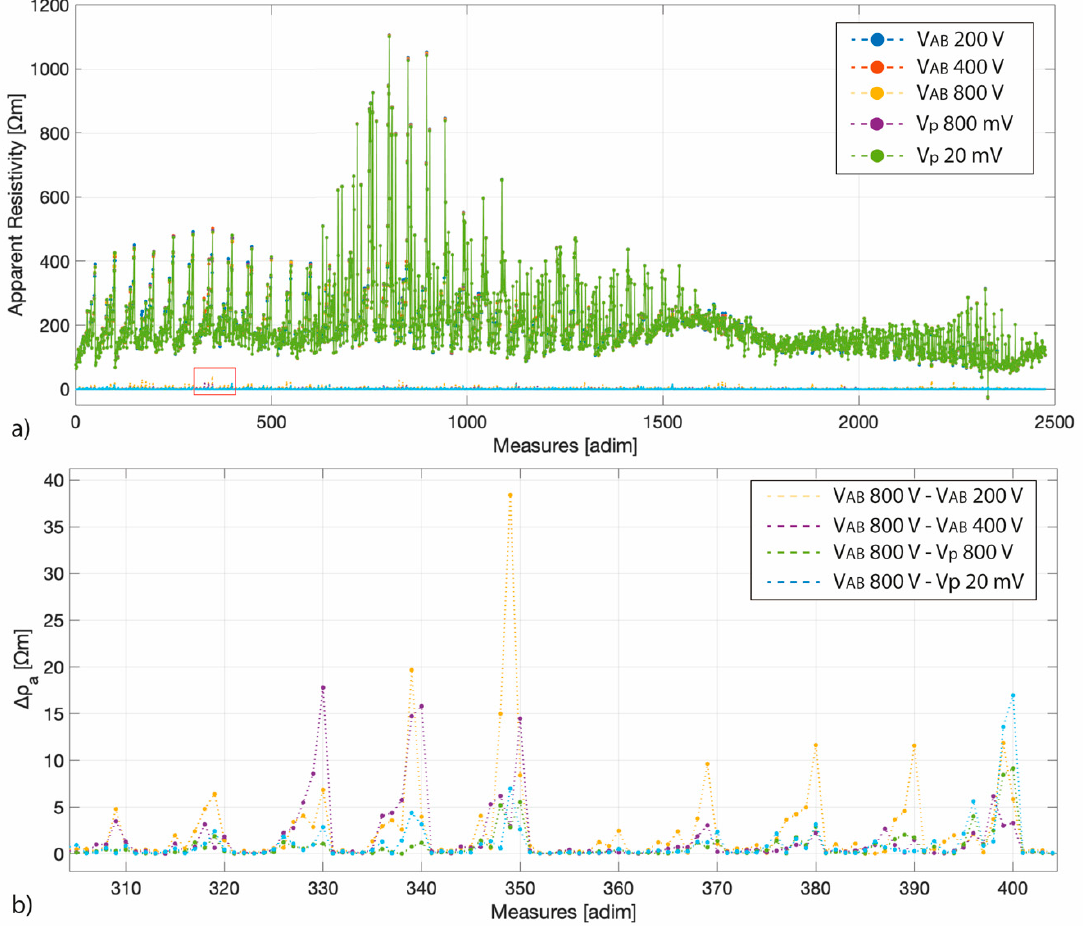
Figure 10. ( a ) The apparent resistivity values collected for each different input voltage and, around zero, the differences between the most energetic input (that with an AB voltage of 800 V) and the others. ( b ) A zoom on the differences of the measures between 305 and 405 (those highlighted by the red rectangle in panel ( a )).